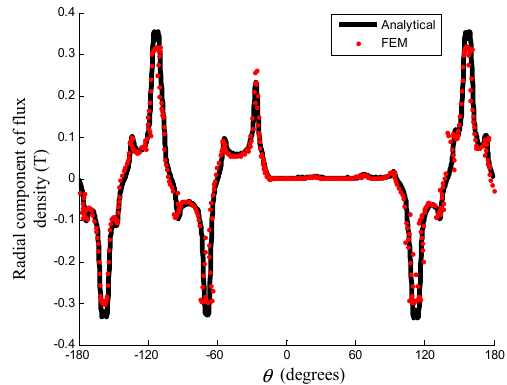
Figure 8. Radial magnetic flux density due to just armature winding in the middle of the air-gap, when the current density of phase A is zero, current density of phase B is 4.33 A/mm 2 and phase C is 4.33 A/mm 2 .